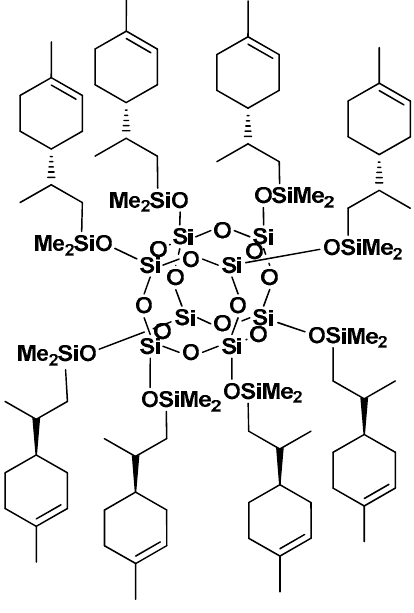
Figure 1. Structure of SS-Limonene.